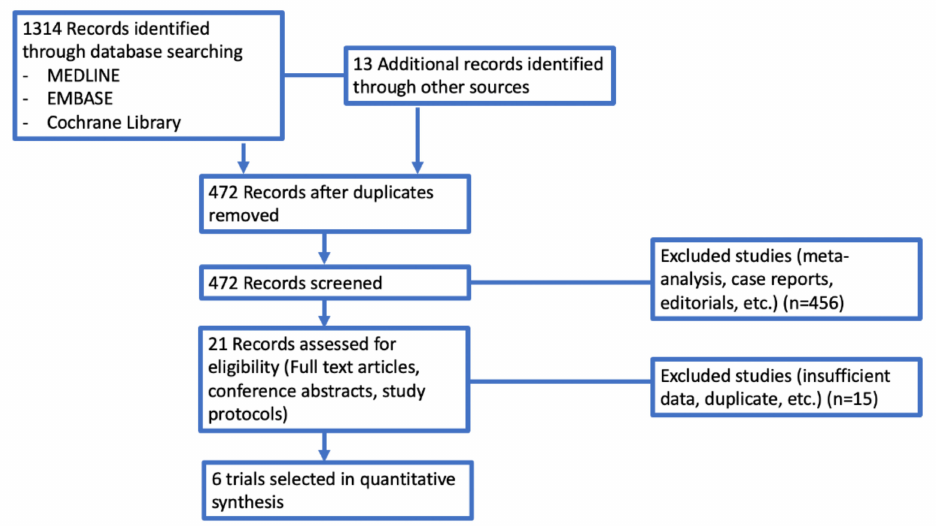
Figure 1. Selection of trials included in the meta-analysis according to PRISMA statement.